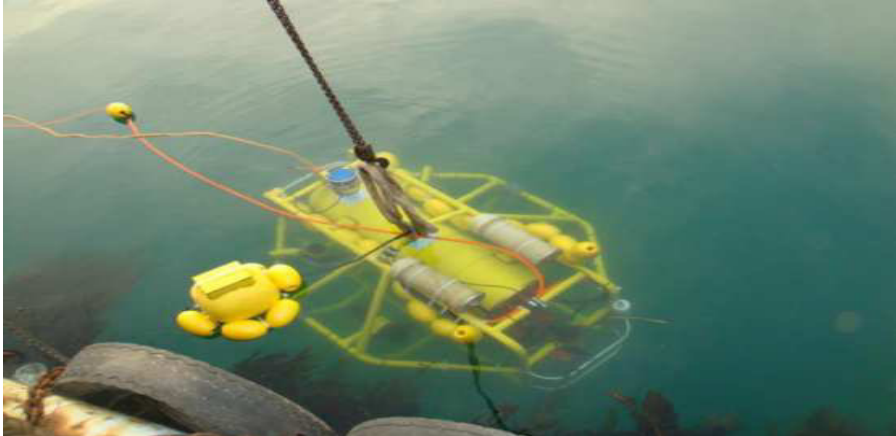
Figure 11. C-Ranger in